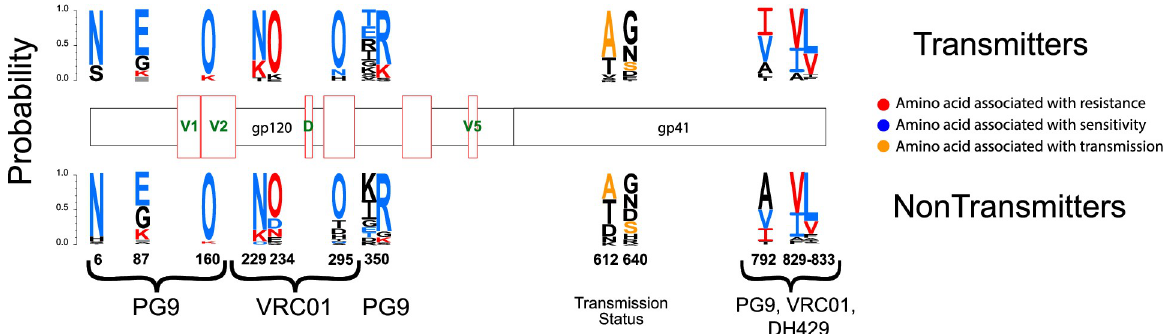
Fig 5. Logo plots of identified signature sequence sites of maternal HIV-1 Env variants that associate with bnAb sensitivity and/or maternal transmission status. Logo plots are shown for each residue that was found to be associated with one of the tested features (see Material and Methods) at the FDR q < 0.05 significance level, grouped by transmitting mothers (top) and non-transmitting mothers (bottom). Each amino acid logo is proportional in size to its relative frequency in the alignment. The letter “O” is used to designate N-linked glycosylation sites. Logos colored in red represent mutated amino acids that conferred resistance to one of the bnAbs tested (shown at the bottom), while logos in light blue represent mutations that conferred sensitivity. Orange denotes amino acids associated with transmission status. Notice that while the logo plots represent the frequency of each amino acid, this doesn’t always reflect the counts of ancestral mutations, which is what is tested in the phylogenetically corrected signature analysis.